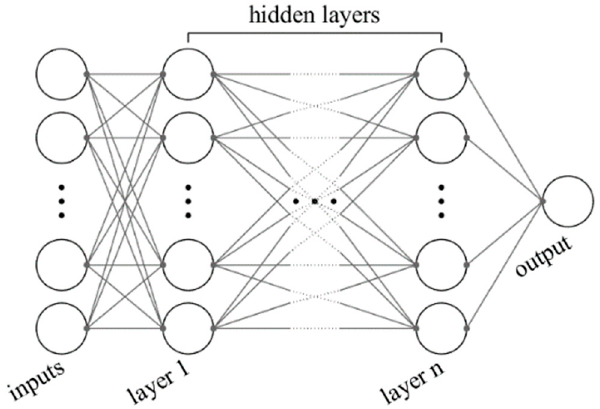
Figure 3. General schematic of an artificial neural network (ANN).